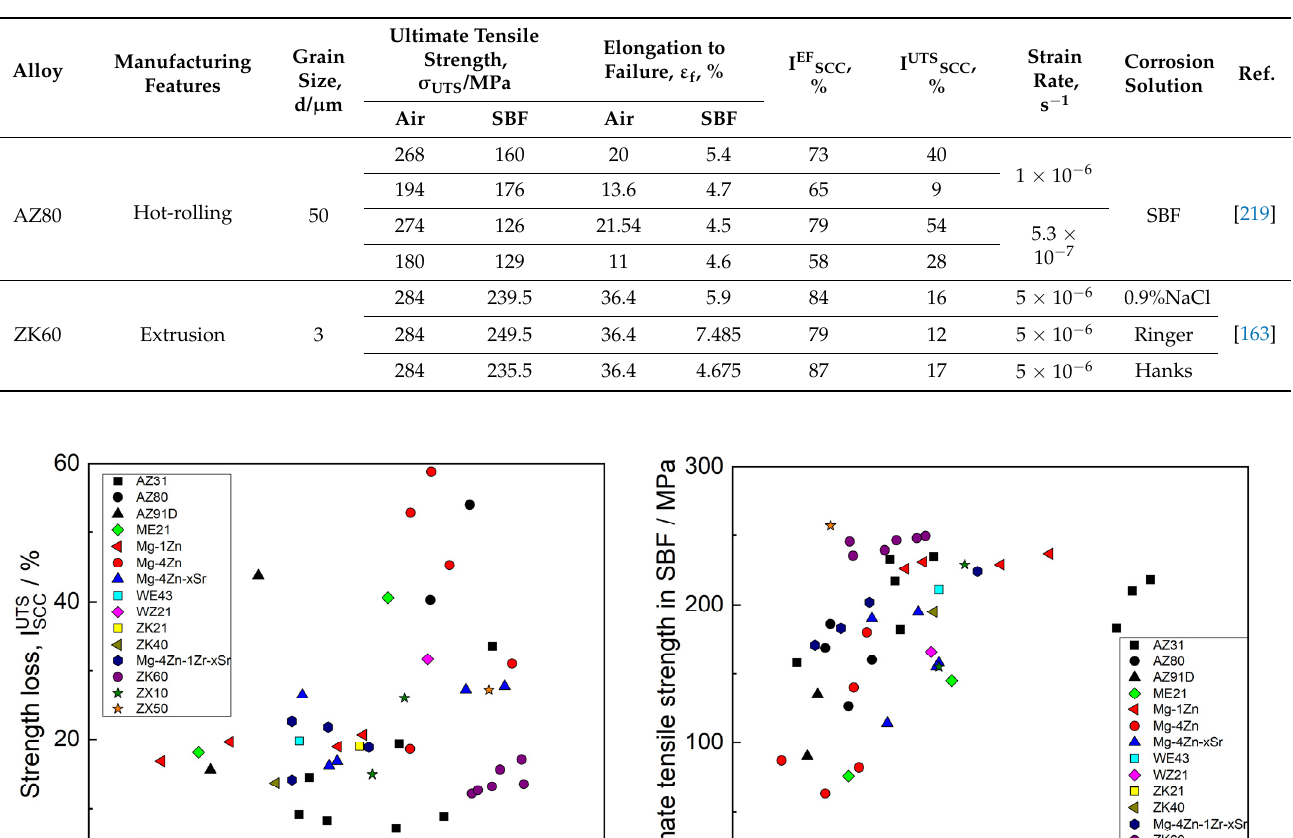
Figure 9. The relationships between the strength level of the biodegradable Mg alloys and their SCC susceptibility indexes by ductility (I EFSCC ) ( a ) and strength (I UTSSCC ) ( b ) in SBFs; data are imported from Table 5 and the references therein.